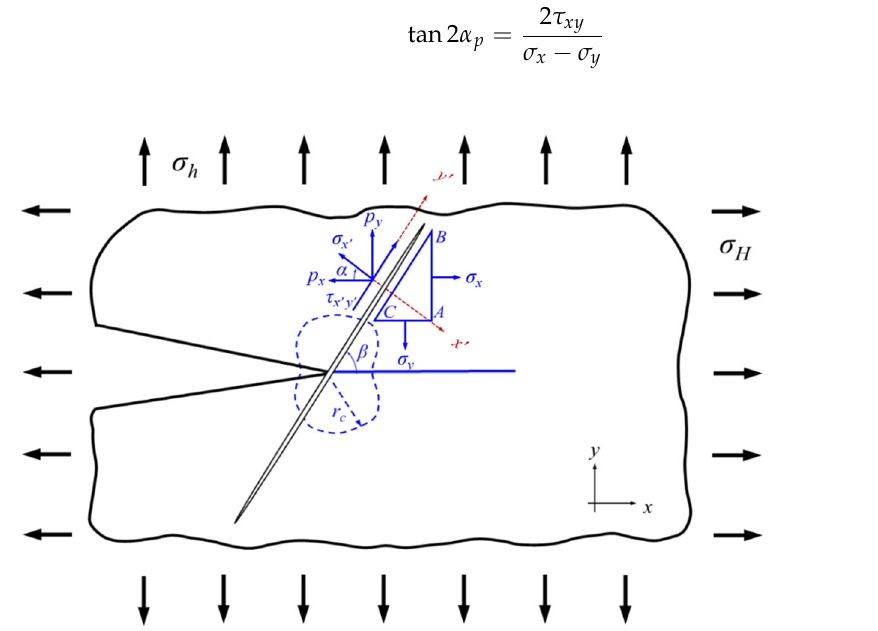
Figure 6. Schematic of a hydraulic fracture (HF) approaching a natural fracture (NF).